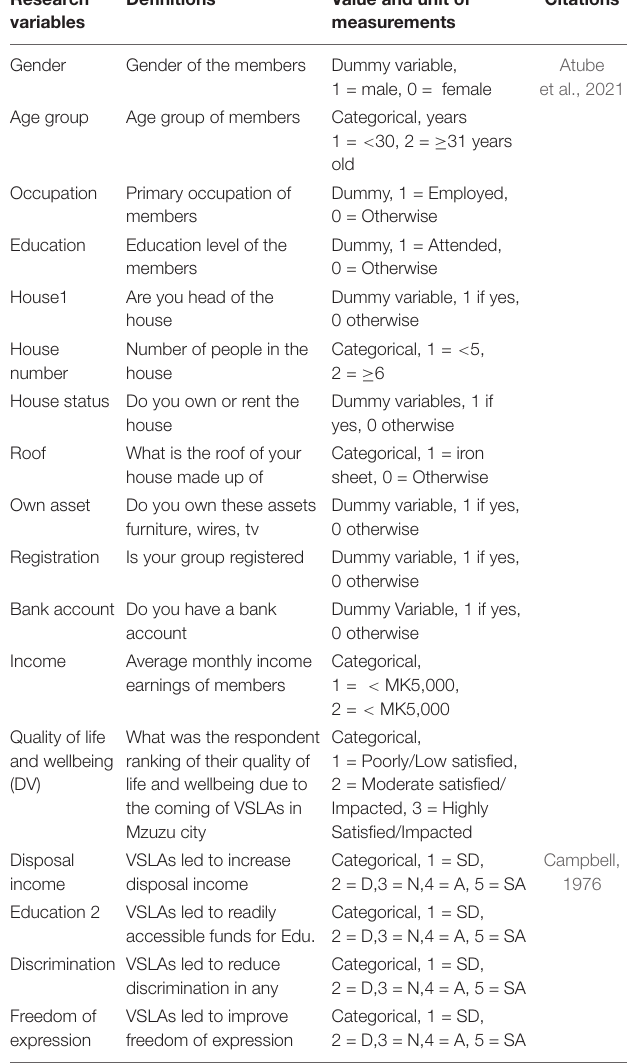
TABLE 2 | Description, definition, and values of variables used in the ordinal regression